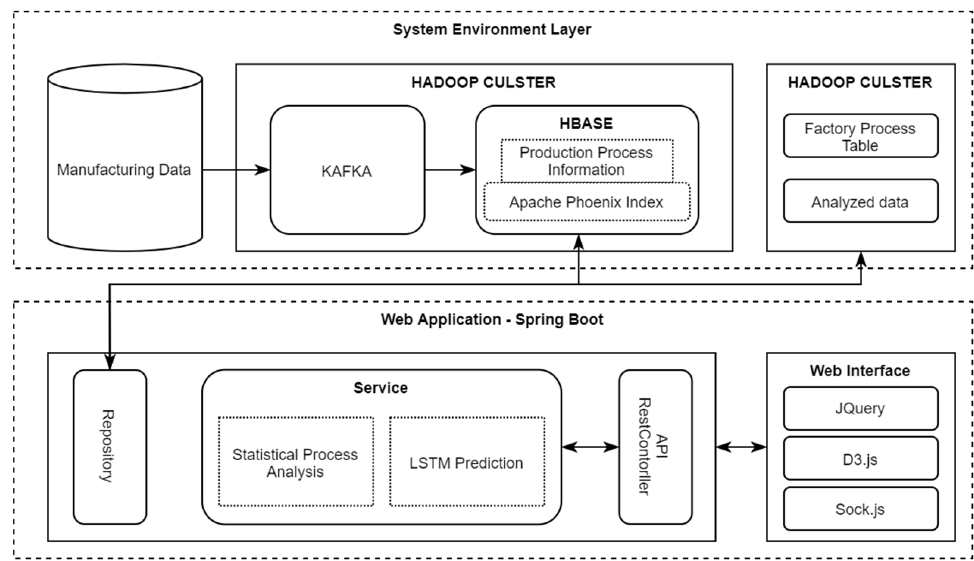
Figure 7. Implementation architecture of the proposed method.